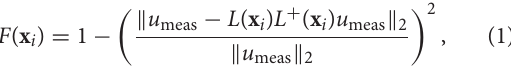
T2-weighted image with an SPC pulse sequence. The MR